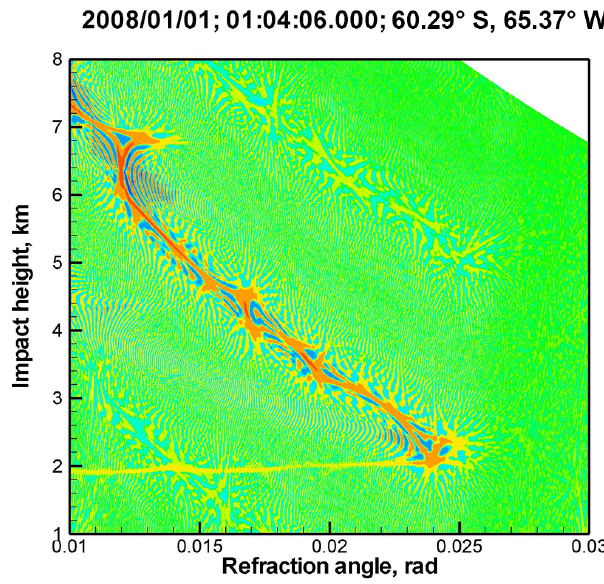
Figure 4. Reflection over ocean.